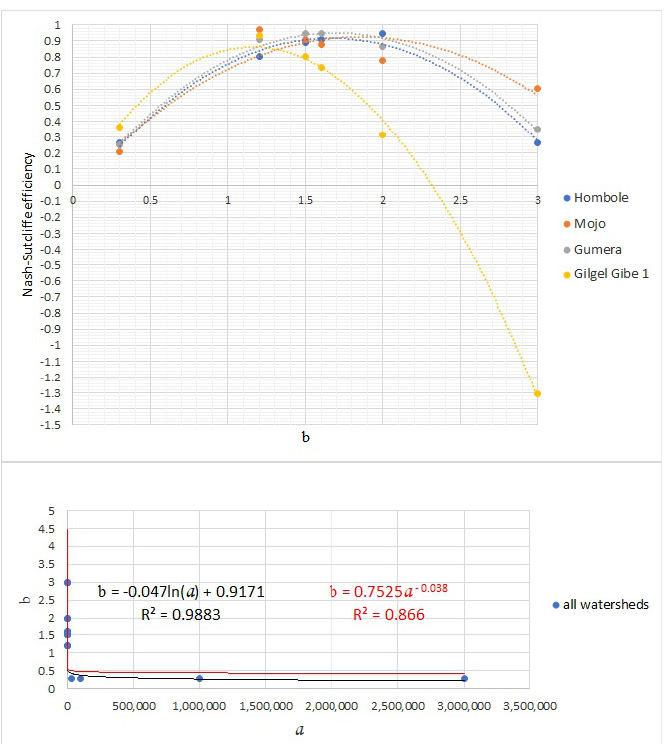
Figure 9. The relationship between exponent b versus the Nash–Sutcliffe efficiency and coefficient a versus exponent b when the topographic factor is calculated by using the equation that was proposed in [31].